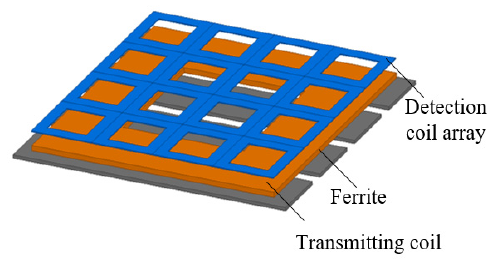
Figure 3. WPT system with detection coil array.